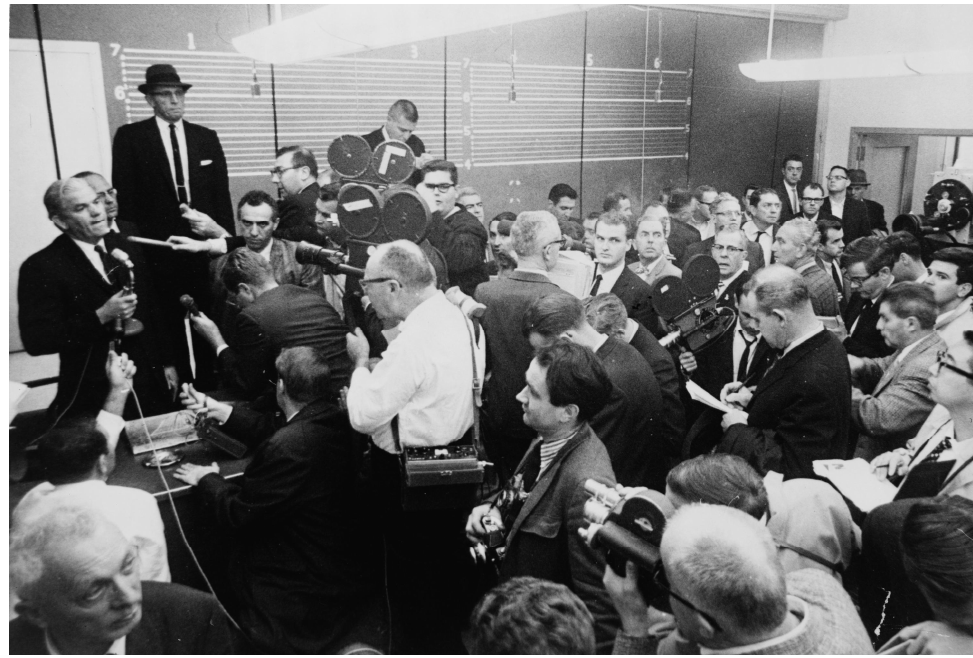
Figure 5. © Bill Sauro/New York Herald Tribune, Wikimedia Commons